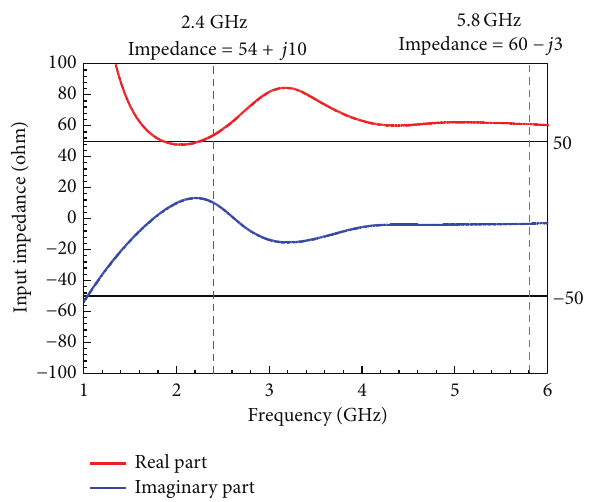
Figure 5: Simulated impedance of the proposed